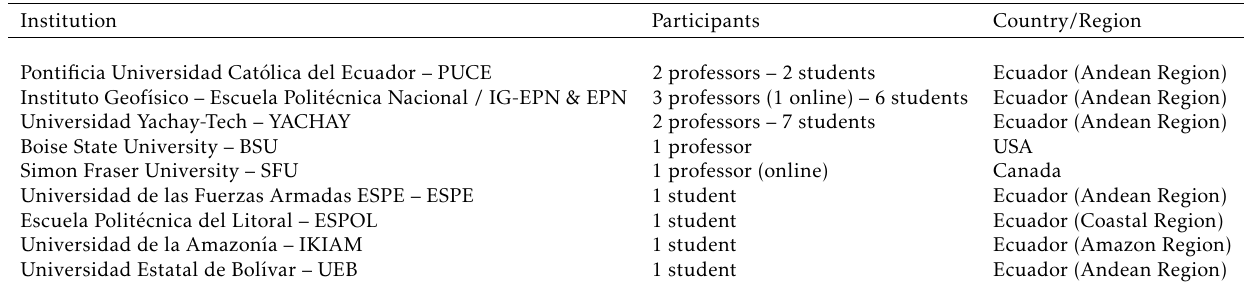
Table 1: Summary of institutions and workshop